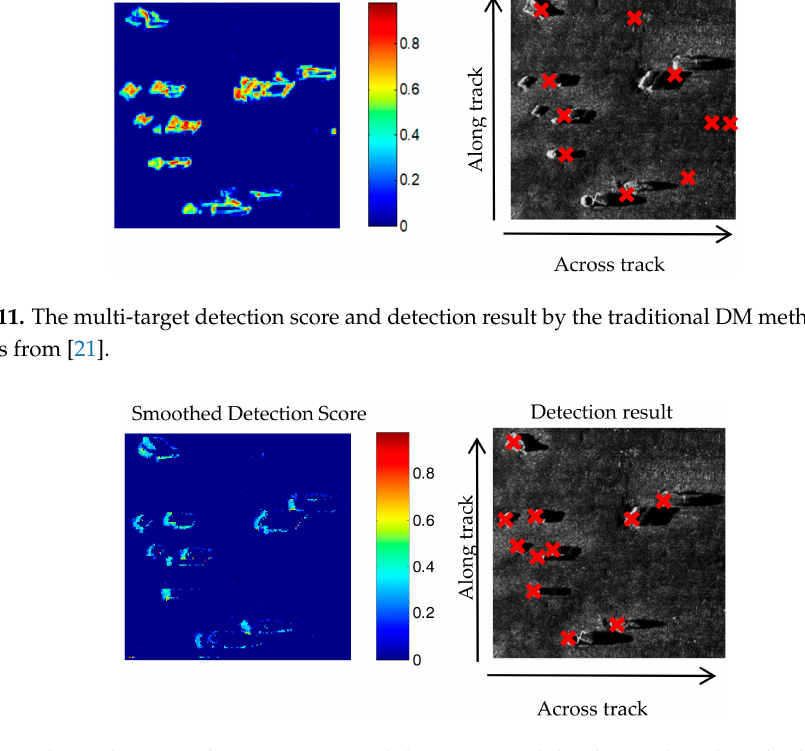
Figure 12. The multi-target detection score and detection result by the combined method (NS + DM).